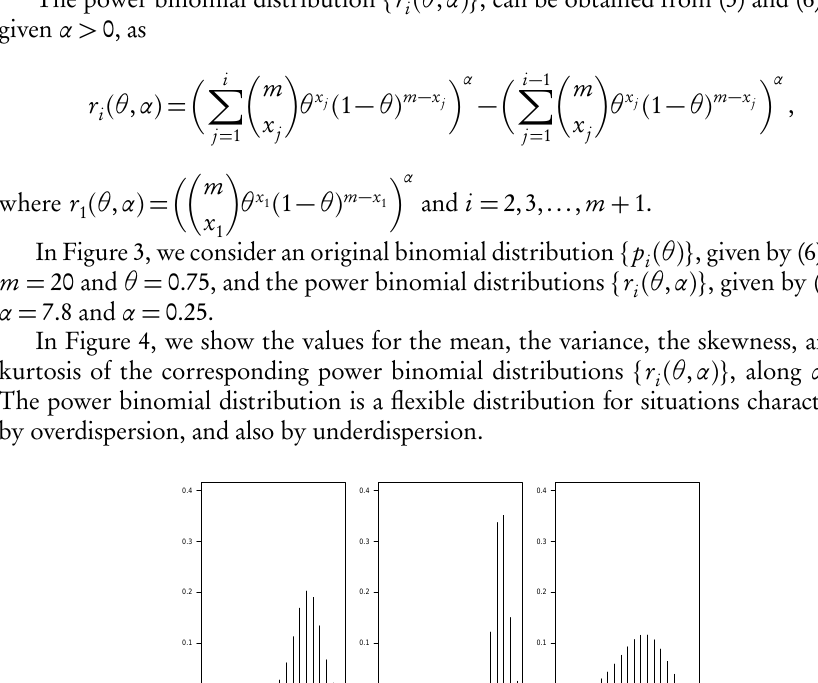
Figure 3 – An original binomial distribution { p and power binomial distributions { r for m = 20, θ = 0.75, and α = 0.25, in panel